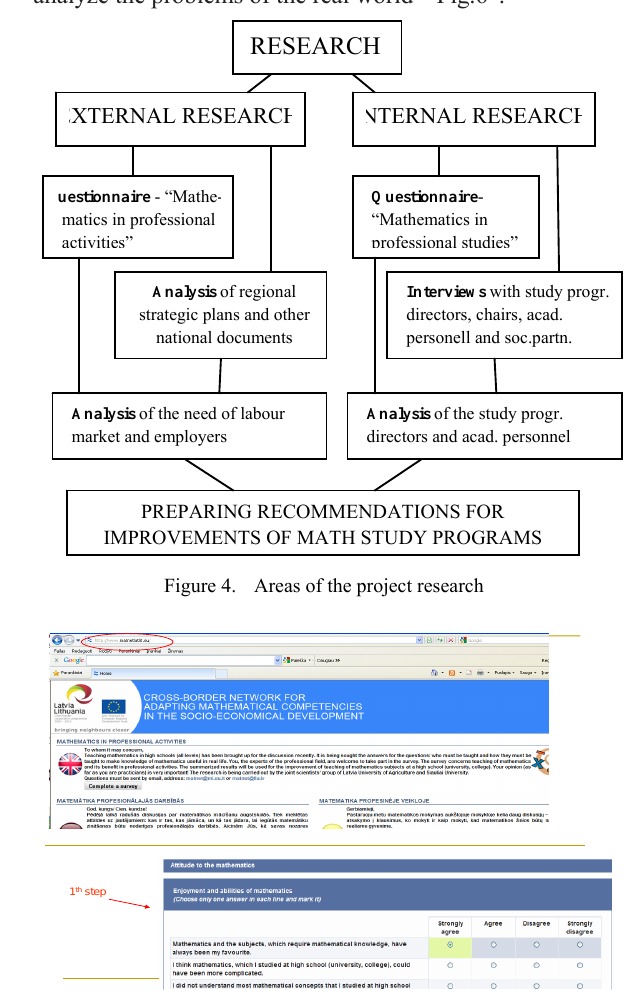
Figure 5. Cross-Border project